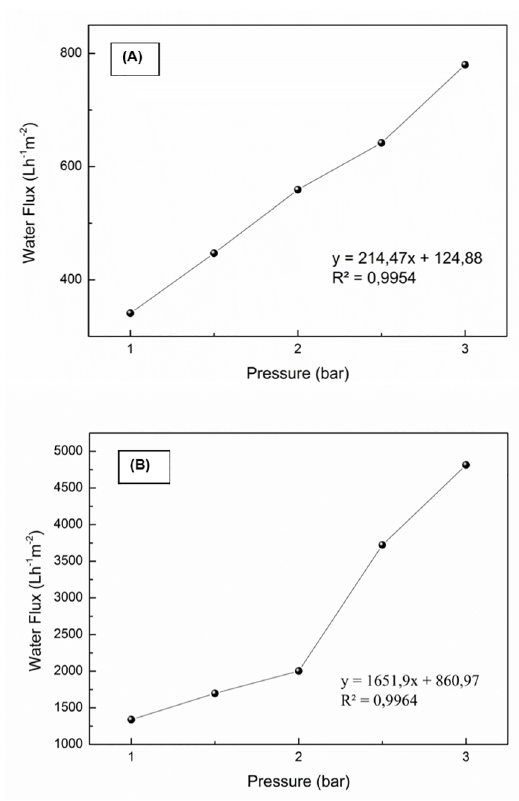
Figure 3. Water permeability using Milli-Q water of the (A) CA-M and (B) CA-Ag-M.